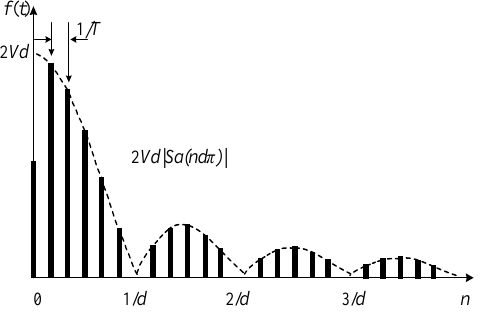
ffi cients of Fourier series Figure 4. The coefficients of Fourier series expansion. Figure 4. The coe